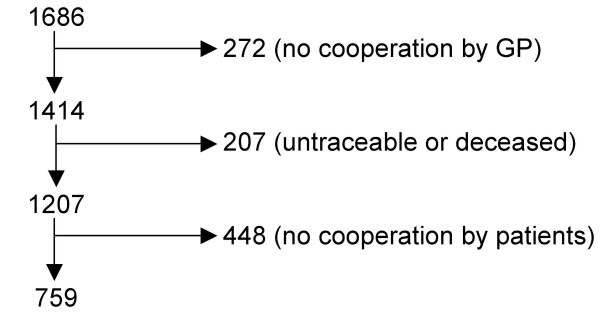
Flow chart of patient inclusion.